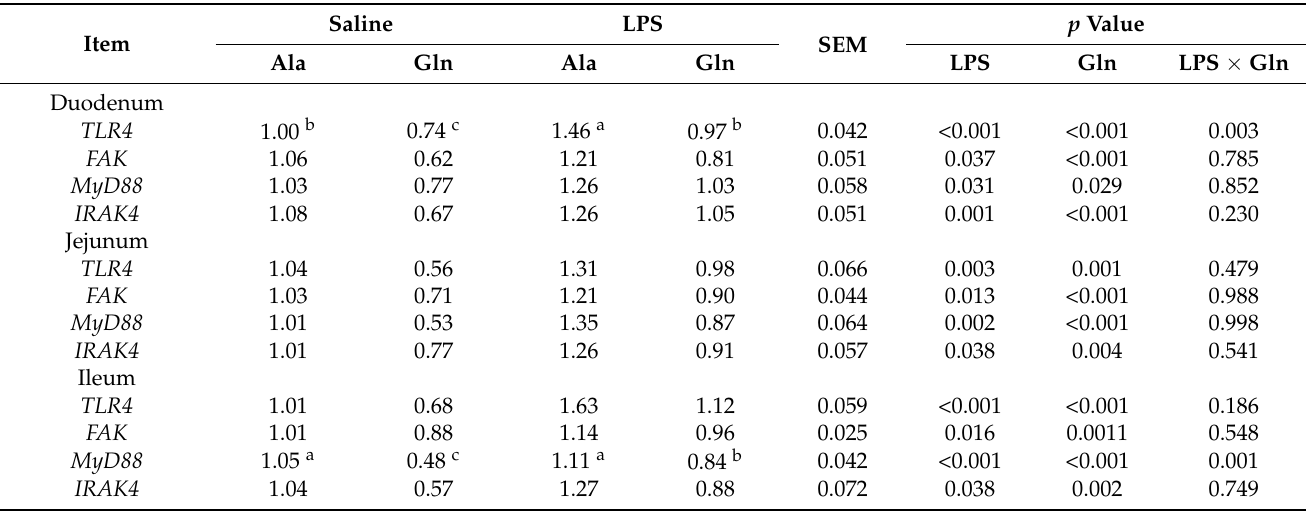
Table 6. Effects of dietary Gln supplementation on mRNA expression of TLR4/FAK/MyD88 signaling in intestine of broilers challenged with LPS 1